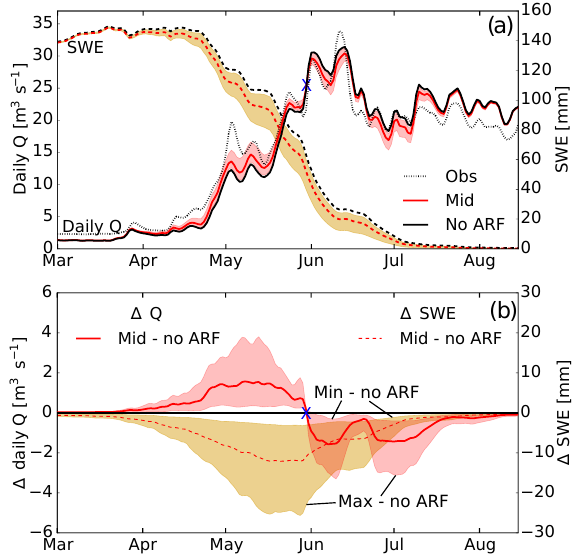
Figure 8. (a) Simulated daily discharge ( Q ; solid lines) and catch- ment mean snow water equivalent (SWE; dashed lines) for the mid (red lines), min, and max (shaded) estimates and for the scenario without ARF (no-ARF; black lines) averaged over the 6-year pe- riod. (b) Differences in daily discharge and SWE between ARF sce- narios and the scenario without ARF (no-ARF). The blue marker in (a) and (b) separates the periods where BC in snow has an en- hancing effect (left of the marker) and a decreasing (right of the marker) effect on